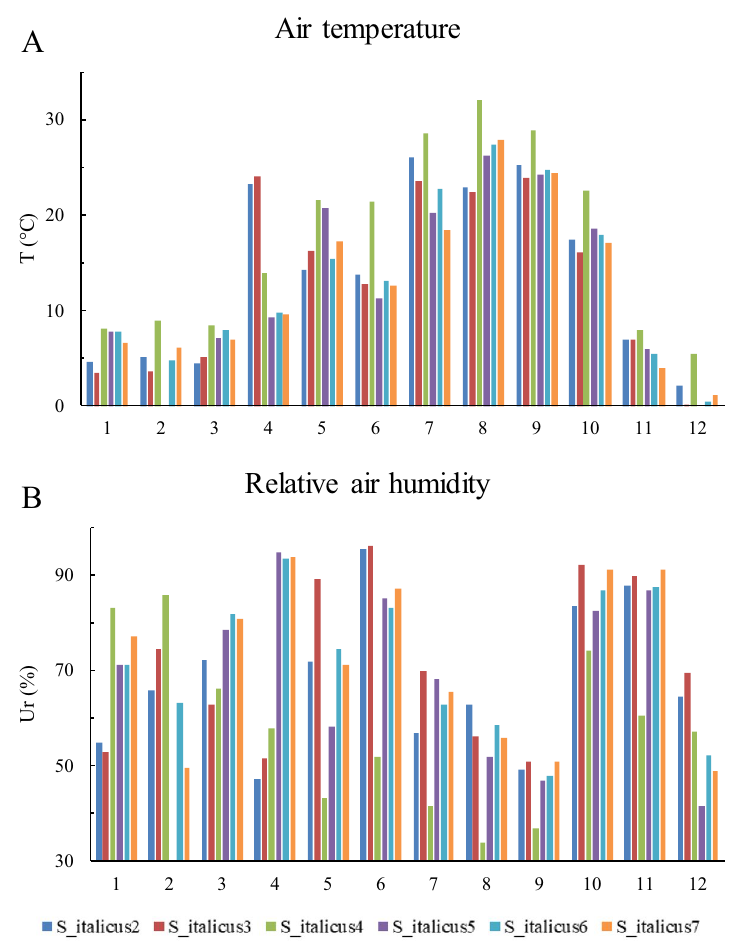
Figure 5. Microclimatic data recorded throughout a year nearby the entrance of the studied caves. Data on air temperature ( A ) and relative humidity ( B ) were monthly collected in a shaded area in the proximity (about 5 m) of the main entrance for each cave. Numbers on x axis indicate months. Data is retrieved from 47